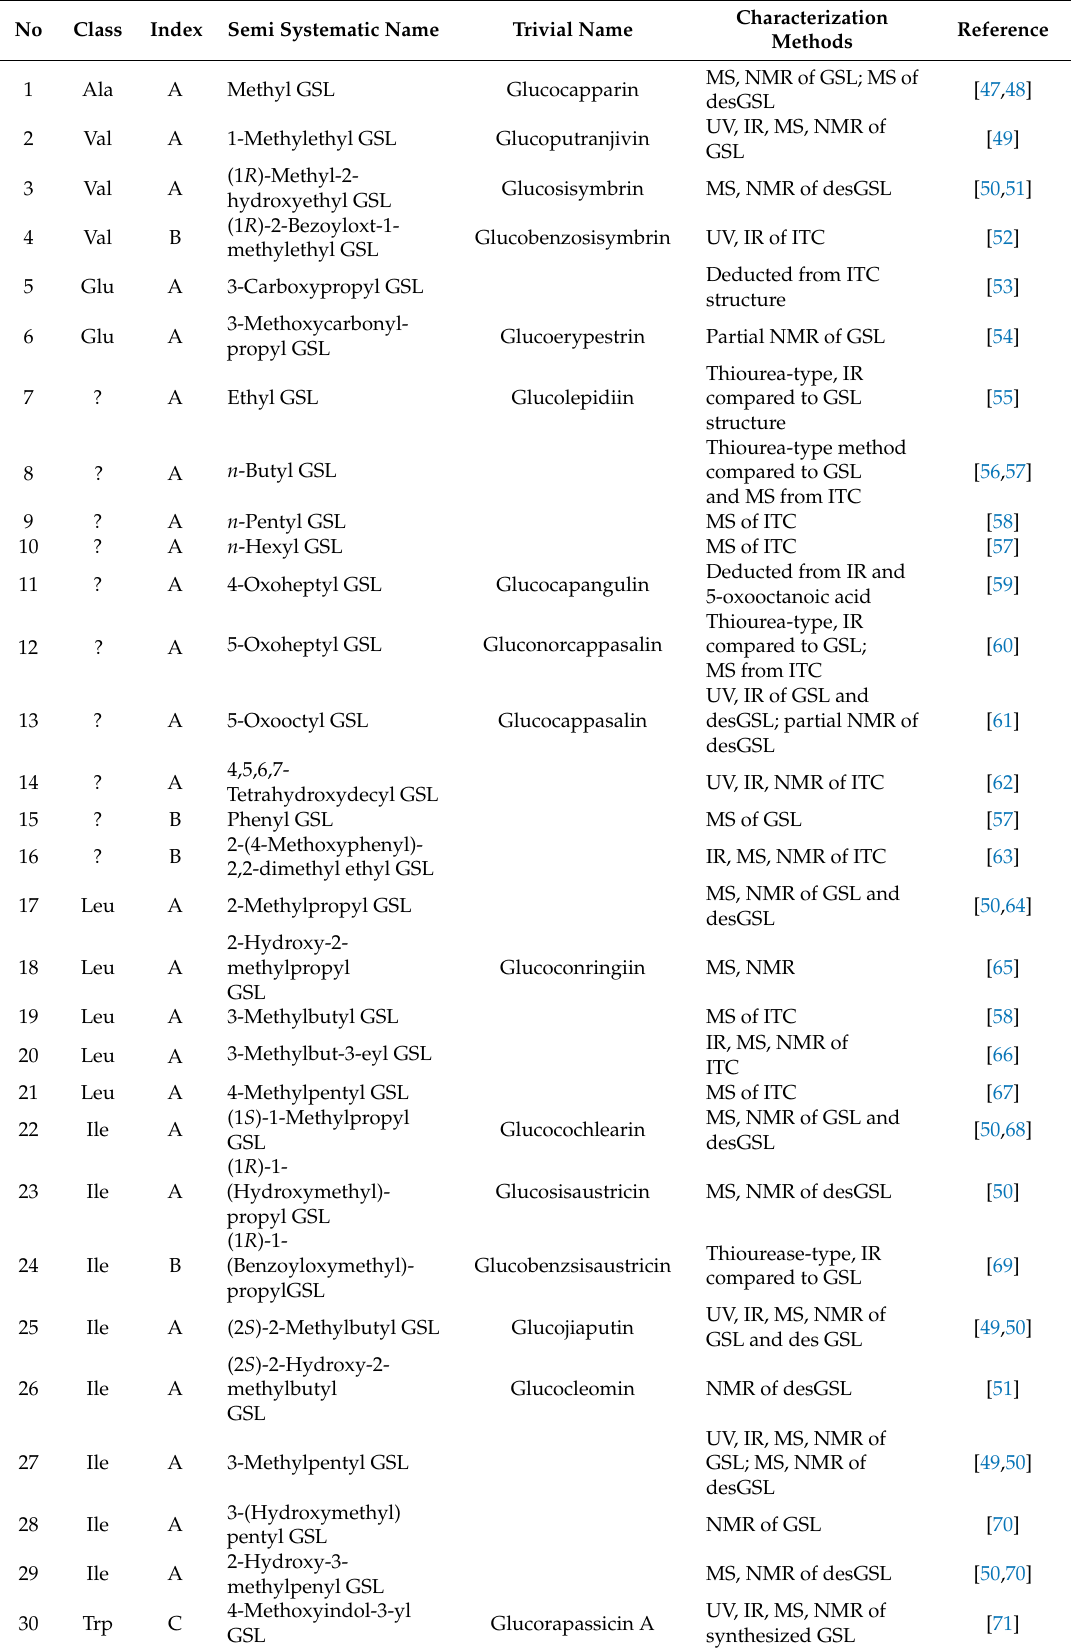
Table 2. Classification of GSL structural examples validated by Blazevic et al. [4]. Index A, B, and C indicate aliphatic, aromatic, and indolic GSLs,